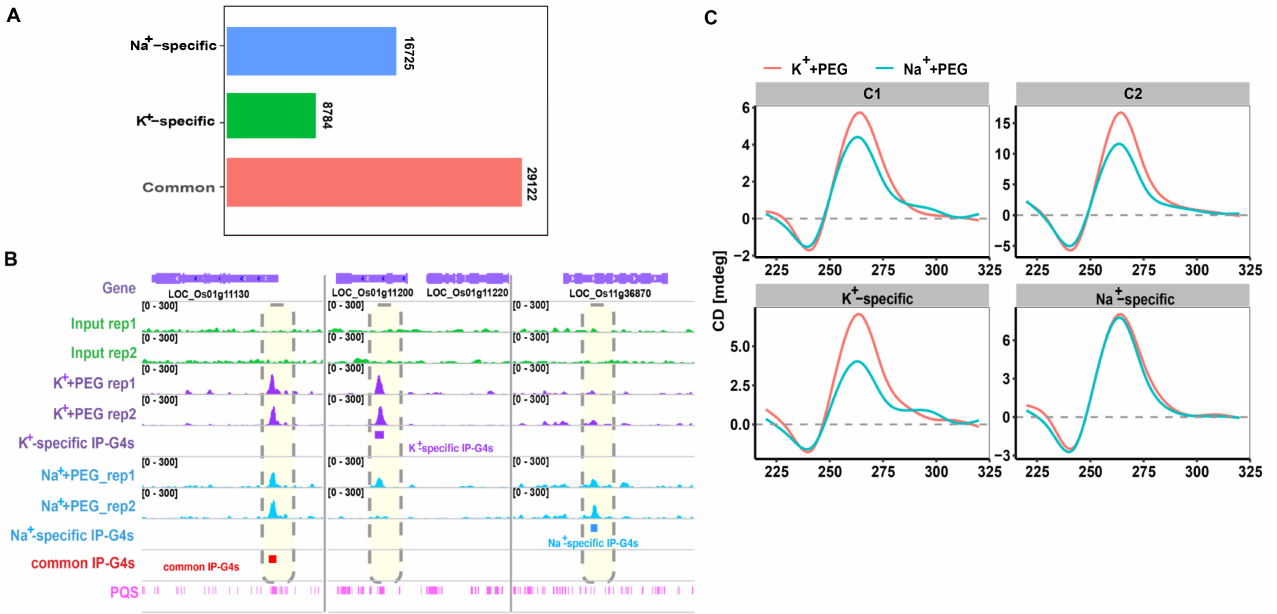
Figure 1. Identification of common and K + -/Na + -specific IP-G4s. ( A ) Histogram illustrating the number of three subtypes of IP-G4s (common and K + -/Na + -specific IP-G4s). ( B ) A representative Integrative Genomics Viewer (IGV) snapshot spanning a 21 kb window, illustrating distributions of common and K + -/Na + -specific IP-G4 peaks in the rice genome. Each significant IP-G4 peak is marked with a colored rectangular box below the peak. Putative G-quadruplexes sequences (POSs) were computationally predicted in the rice genome. ( C ) Circular dichroism (CD) spectroscopy assays using synthesized oligoes for common and K + -/Na + -specific IP-G4s,